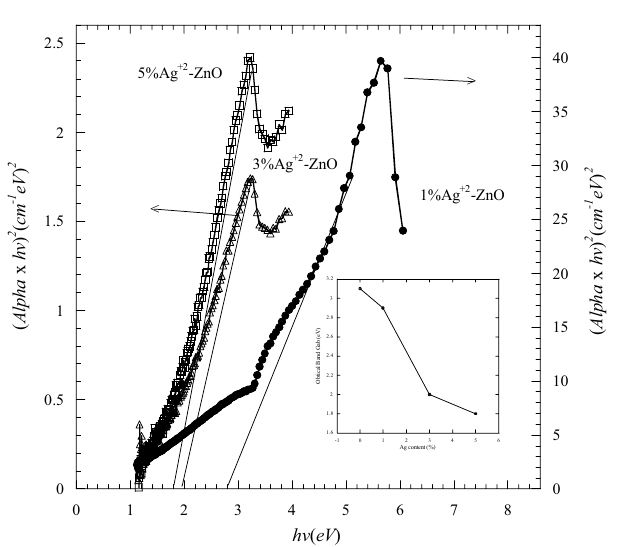
2 Figure 8. (α h ν) versus the photon energy ( h ν ) of pure and Ag doped ZnO nanopowders. The inset is the energy gap of samples as a function of Ag